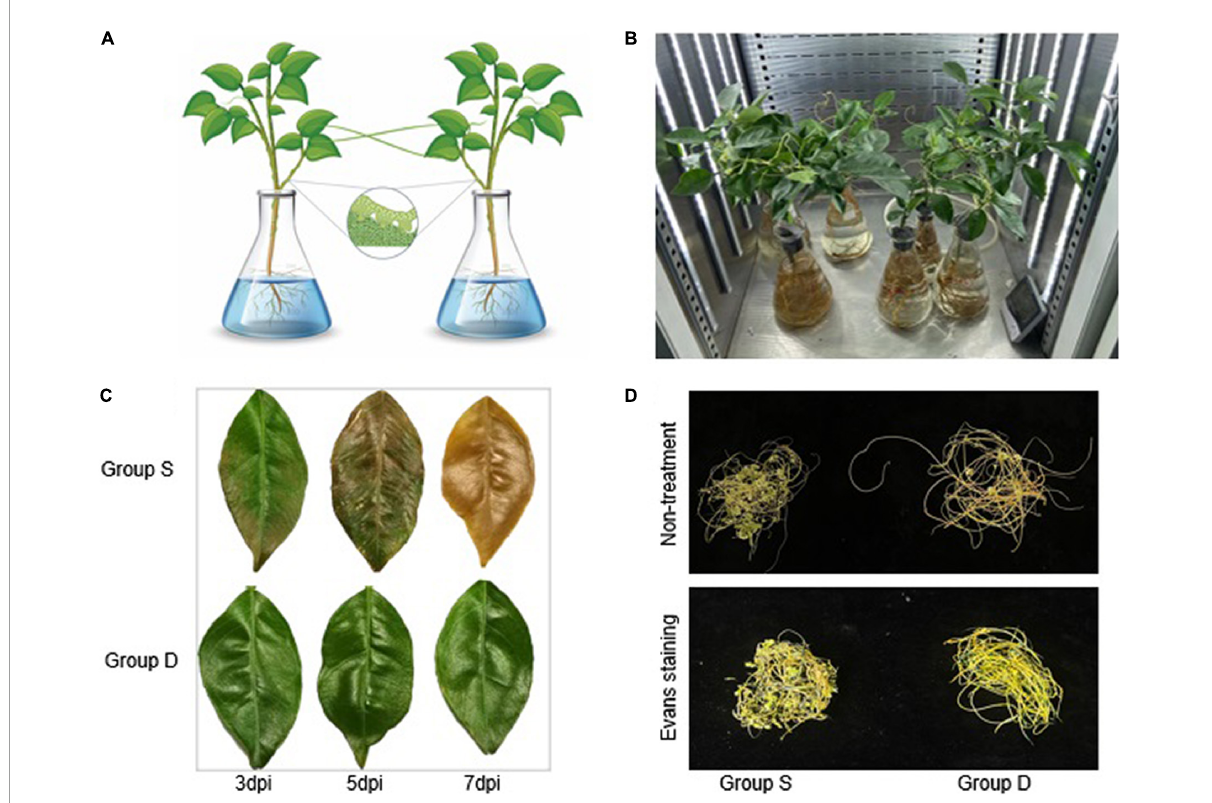
FIGURE1 Experimental setup in this study. (A) Schematic of the experimental design for citrus-dodder-citrus community. (B) Group D, Group S, Mock, and the control group were set up in the growth chamber for phenotypes observation. The control group was mock-treated, while in group S, the citrus was treated with 500 mM NaCl. (C) The experimental groups citrus leaves for electrolyte leakage to monitor the cell viability during salinity treatment. (D) The dodder phenotypic observation in Groups S and D at 72